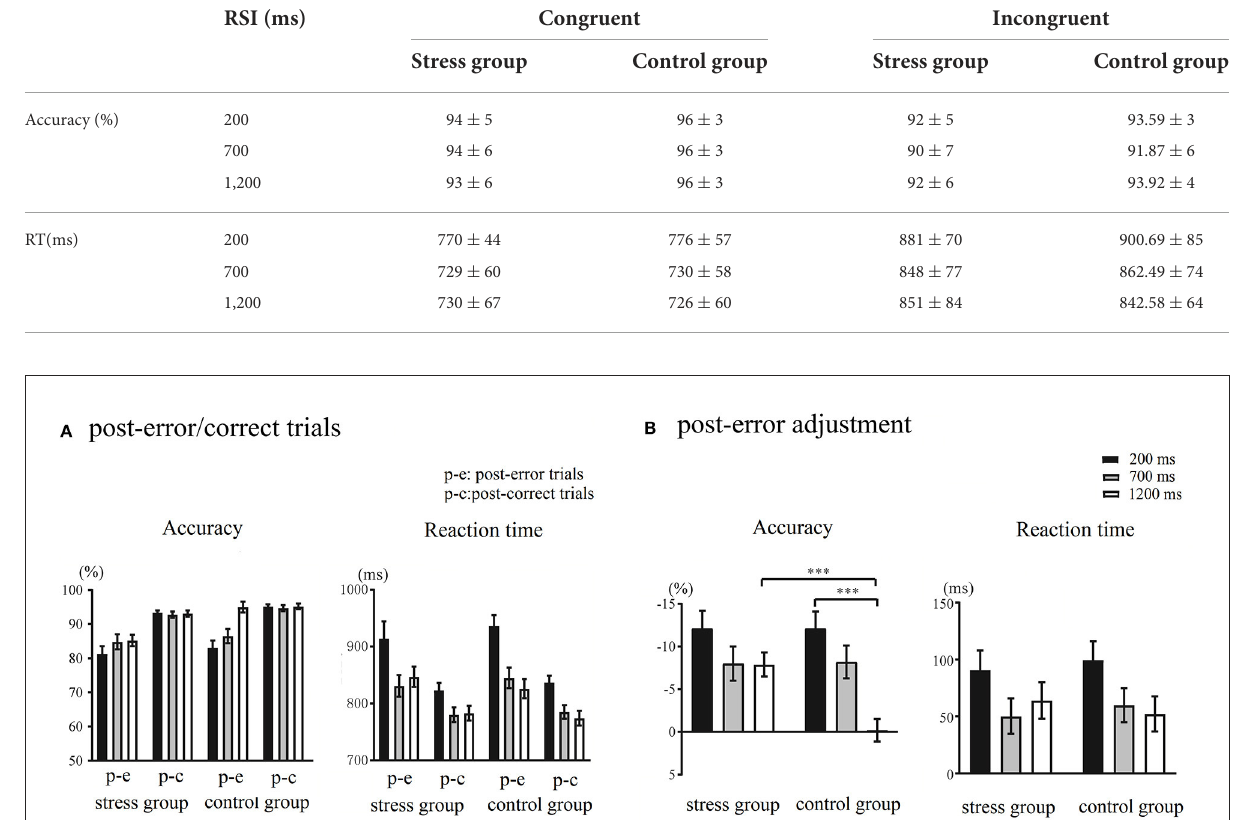
RTs post – − error adjustment = − error trial